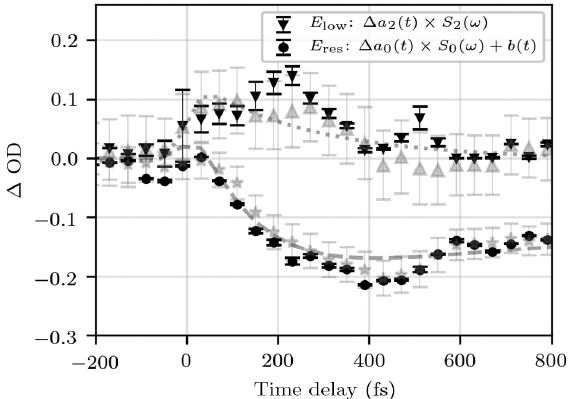
FIG. 7. Lineouts through the resonant energy region ( E ) and res ð rec Þ ð E; t Þ the low-energy region ( E ) of the reconstructed Δ OD 0 ; 2 low with only specific channels ( a 0 , respectively a 2 ) included. All other contributions are set to zero. For comparison, the exper- imental Δ OD ð E; t Þ trace with its bi-exponential fit [cf. Fig. 3 and Eq. (1)] is shown in the